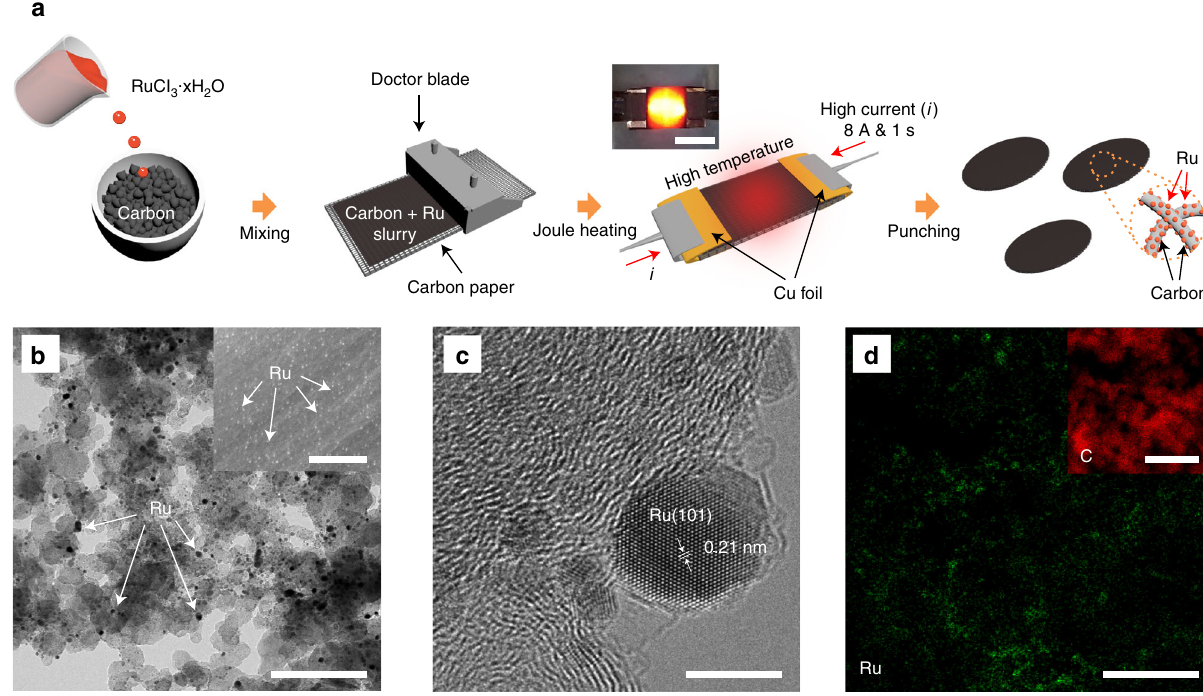
Fig. 5 Joule heating induced Ru nanoparticles. a Schematic illustration of the fabrication procedure of Ru nanoparticles on the carbon cathode by using the Joule heating method. The inset shows a photograph of light emitting from the carbon cathode during Joule heating. Scale bar is 1 cm. b Bright- fi eld TEM micrograph and SEM image (inset) of the carbon cathode with Ru nanoparticles after applying 8 A for 1 s. Scale bars are 200 nm. c High-resolution TEM image of Ru nanoparticles on the carbon cathode. Scale bar is 5 nm. d EDS mapping of Ru and C (inset) elements of the TEM image in ( b ). Scale bars are 200 nm.